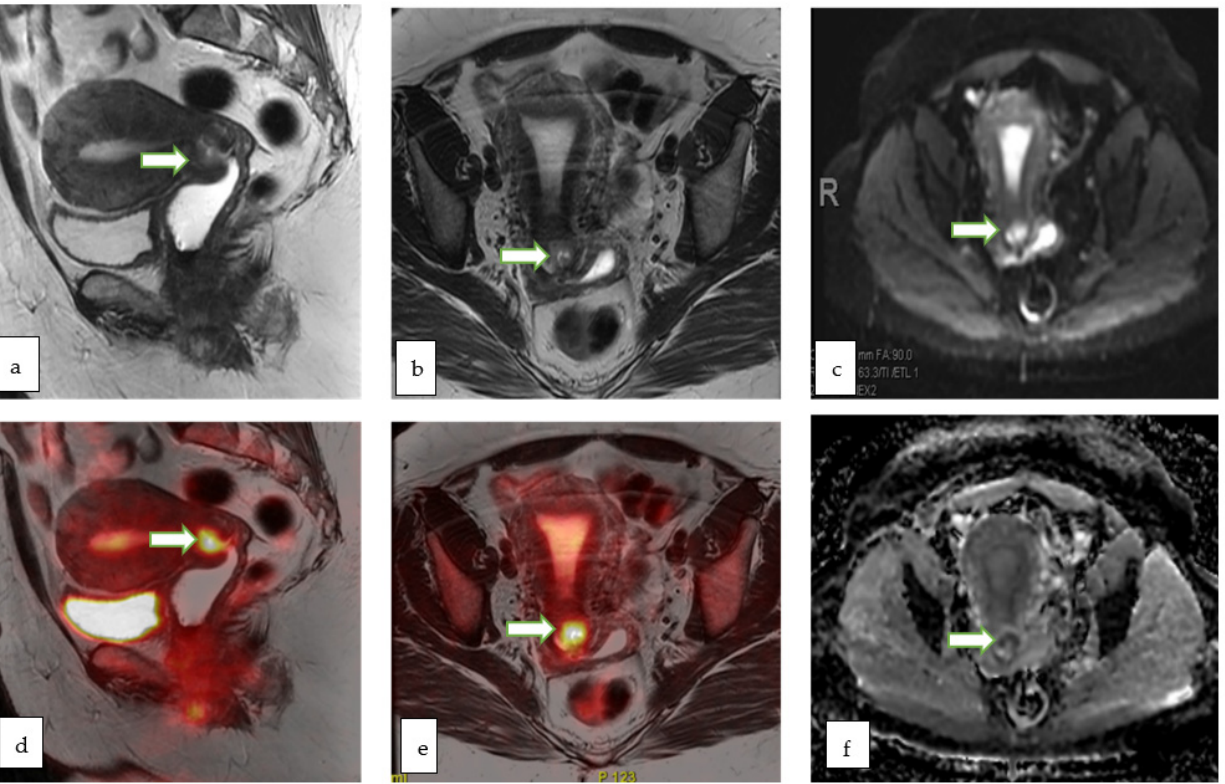
Figure 13. Sagittal T2W ( a ) and axial T2 W ( b ) MR images of a 51 year old lady with abnormal vaginal bleeding show a 2.3 × 2.1 cm endocervical mass involving the anterior cervical lip. The lesion appears bright on DWI ( c ) and shows low ADC ( f ) values consistent with diffusion restriction. Sagittal ( d ) and axial ( e ) color fused PET-MR images showed the corresponding FDG avid hypermetabolic with maximum SUV of 10.7. Mild uptake within the endometrial cavity was thought to be physiologic. Biopsy of the cervical mass revealed basaloid type invasive moderately differentiated squamous cell carcinoma of the cervix.